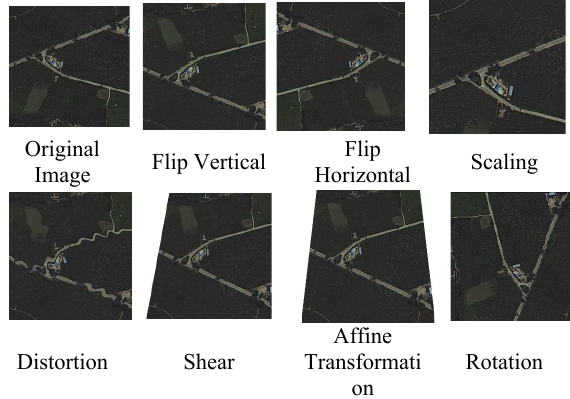
Fig.1 Effect of Geometric